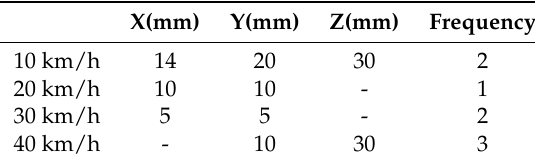
Table 5. Amplitude and frequency at different